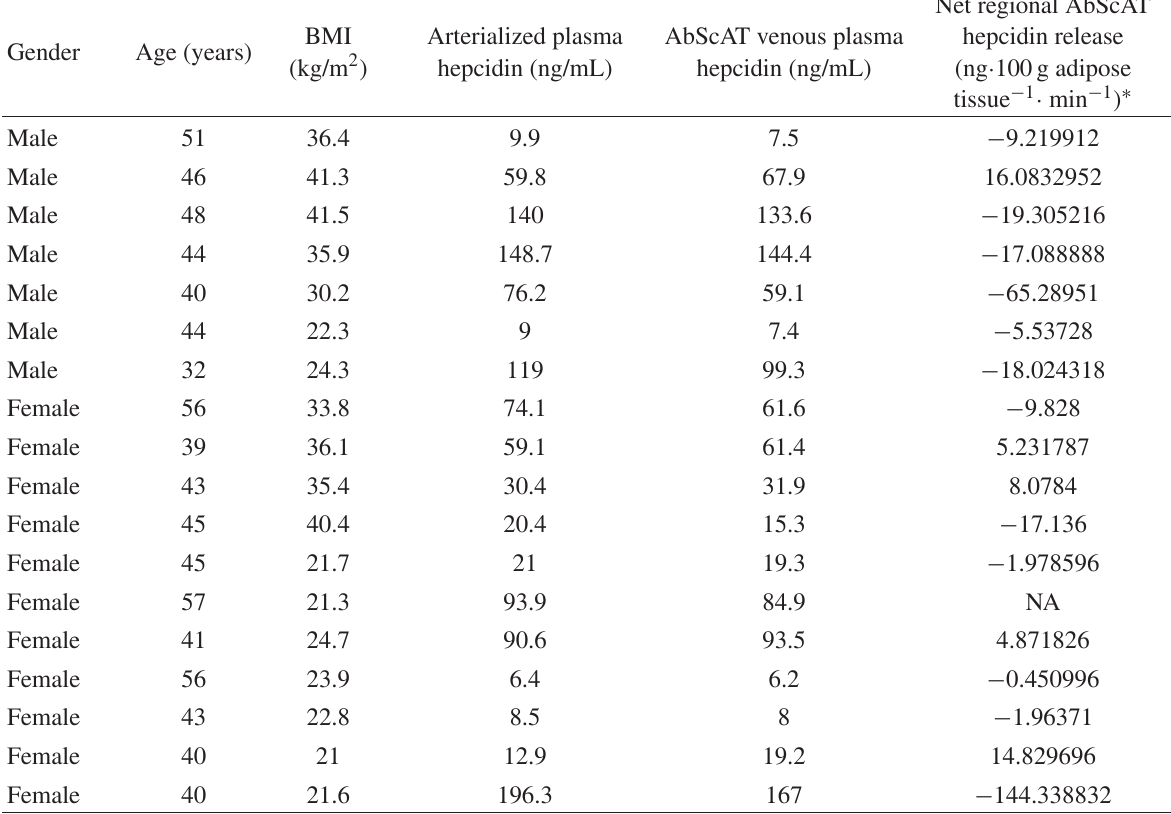
TABLE 2: Demographic, body mass index, arterialized plasma and abdominal subcutaneous adipose tissue (AbScAT) venous plasma hepcidin concentrations, and in vivo net regional hepcidin release from AbScAT in obese ( n = 9 ) and lean ( n = 9 )